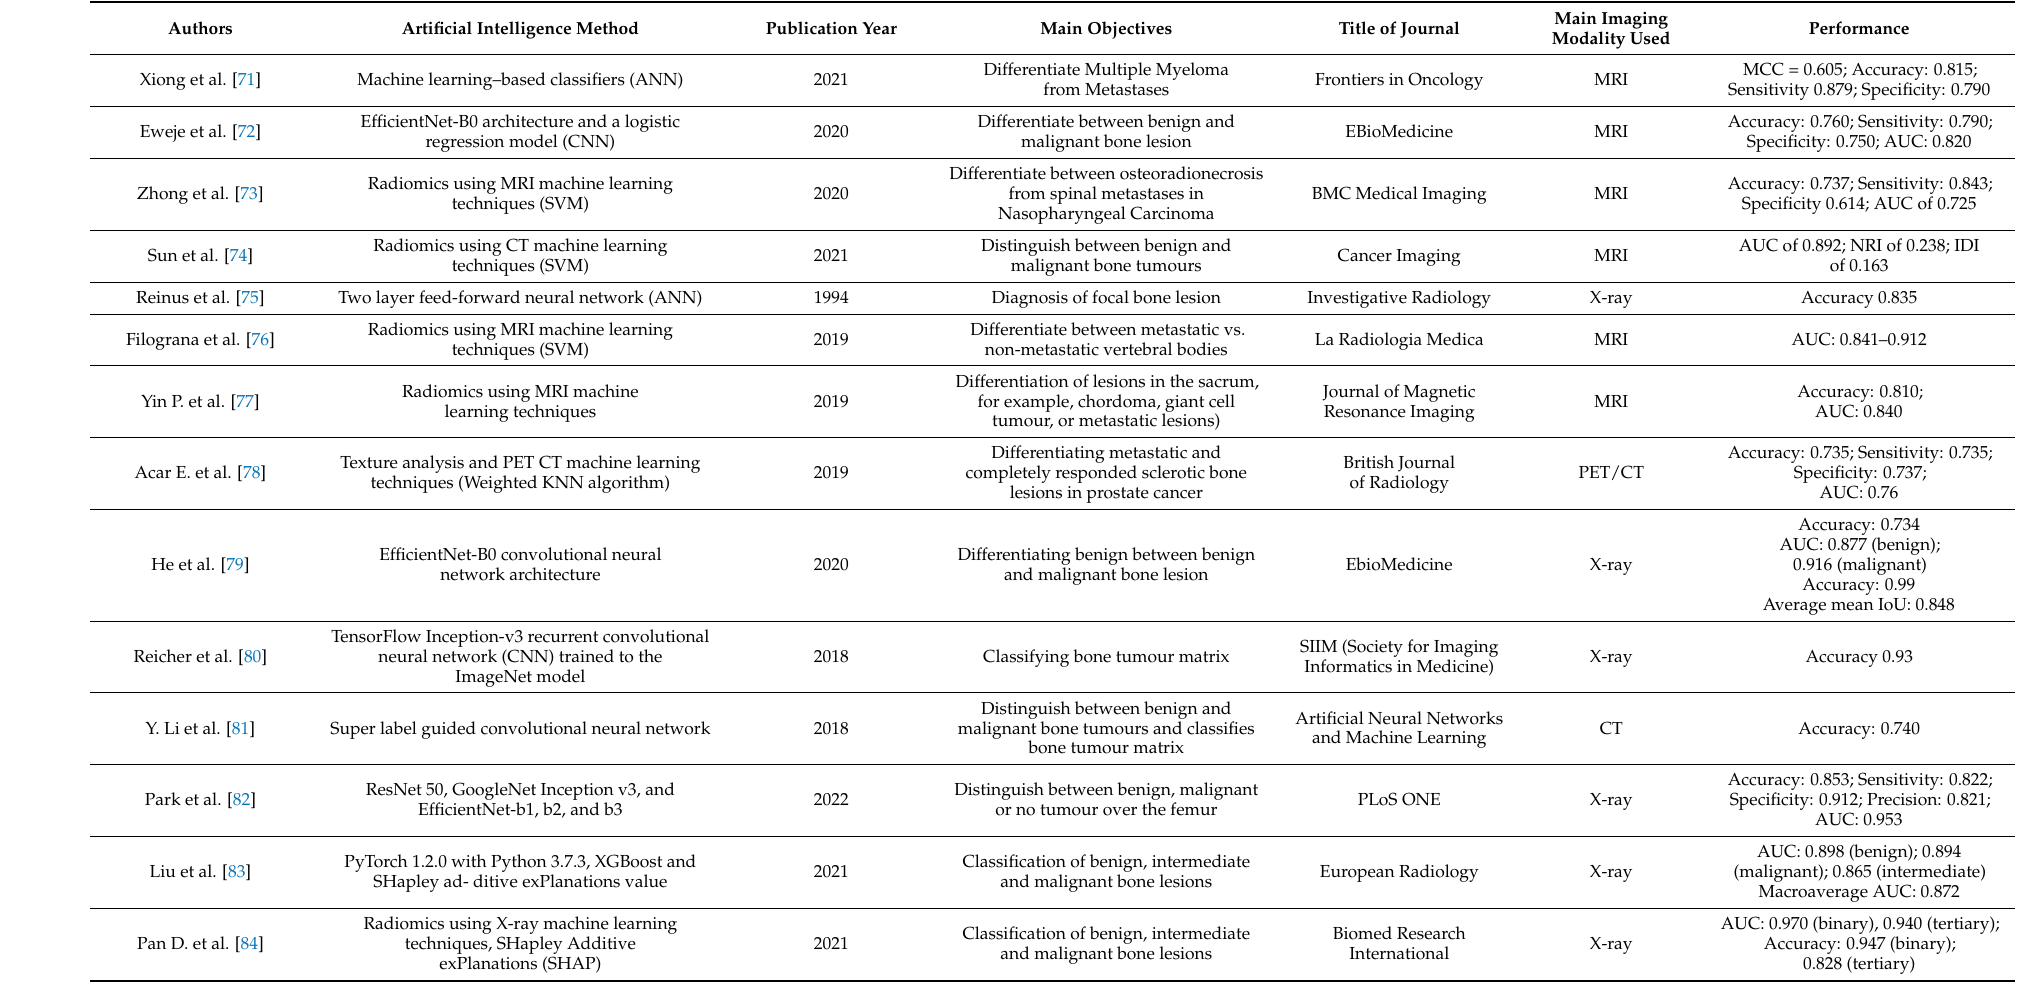
Table 1. Key characteristics of the selected research